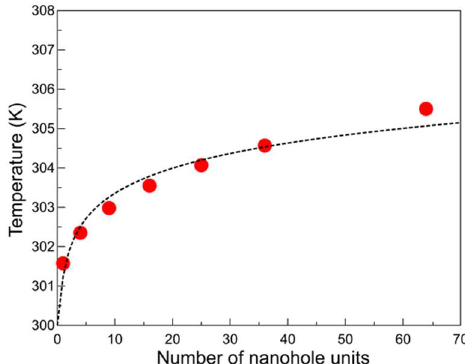
Figure 4. Dependence of plasmonic local heating on array size. Simulated local heating temperatures as a function of the numbers of nanoholes in the array (red circles). The dashed line indicates a logarithmic fit to the simulation results.